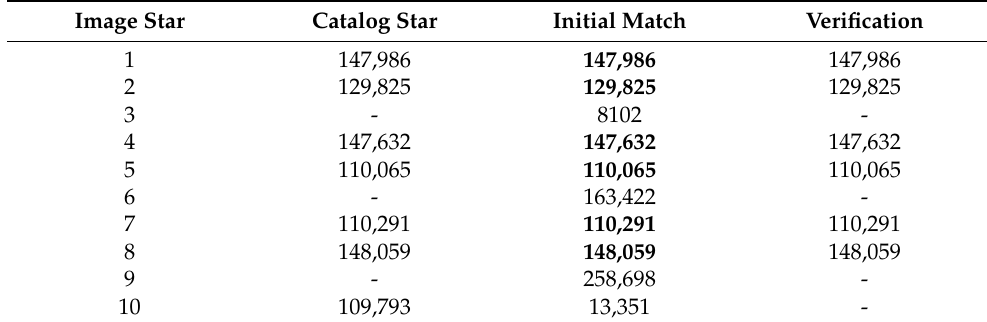
Figure 4. An identification example: ( a ) star image to be identified; ( b ) identification results with the proposed method. Table 3. An identification example of the